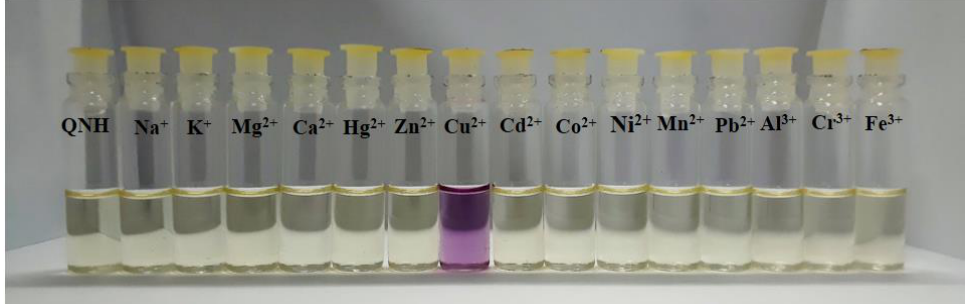
Figure 1. Visible colour change of QNH after addition of cations in HEPES−buffer/acetonitrile (3/7, v / v ) medium. The concentration of the metals in all vials is 10 −4 M.